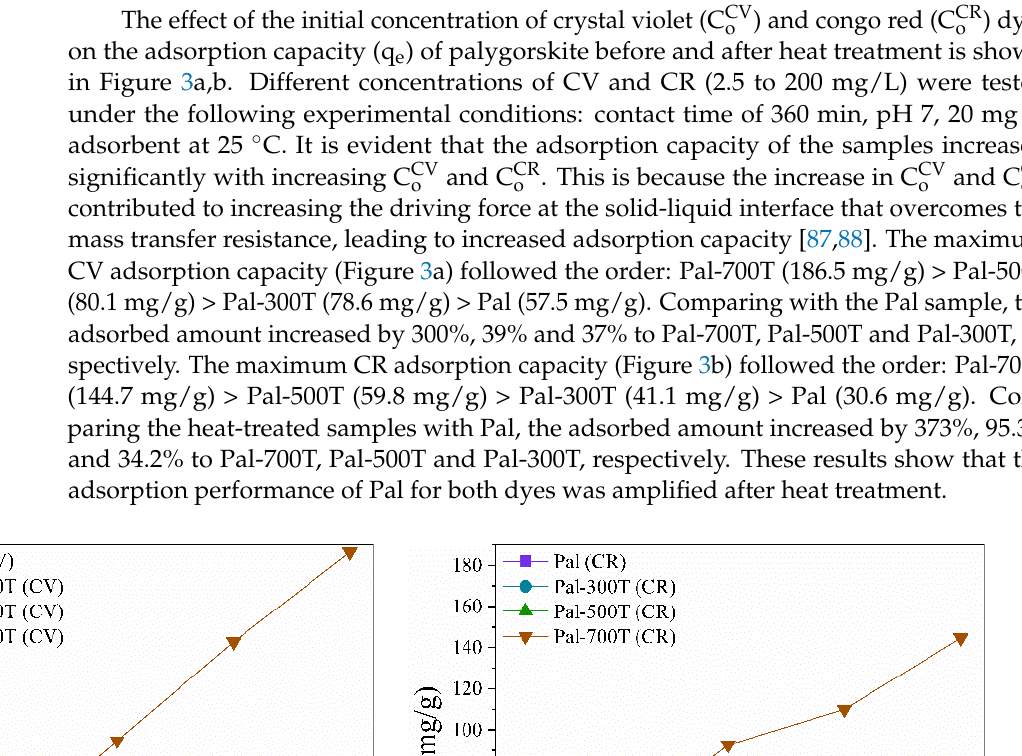
Table 2. Specific surface area (S BET ) and average pore diameter (D p ) of palygorskite before and after heat treatment.